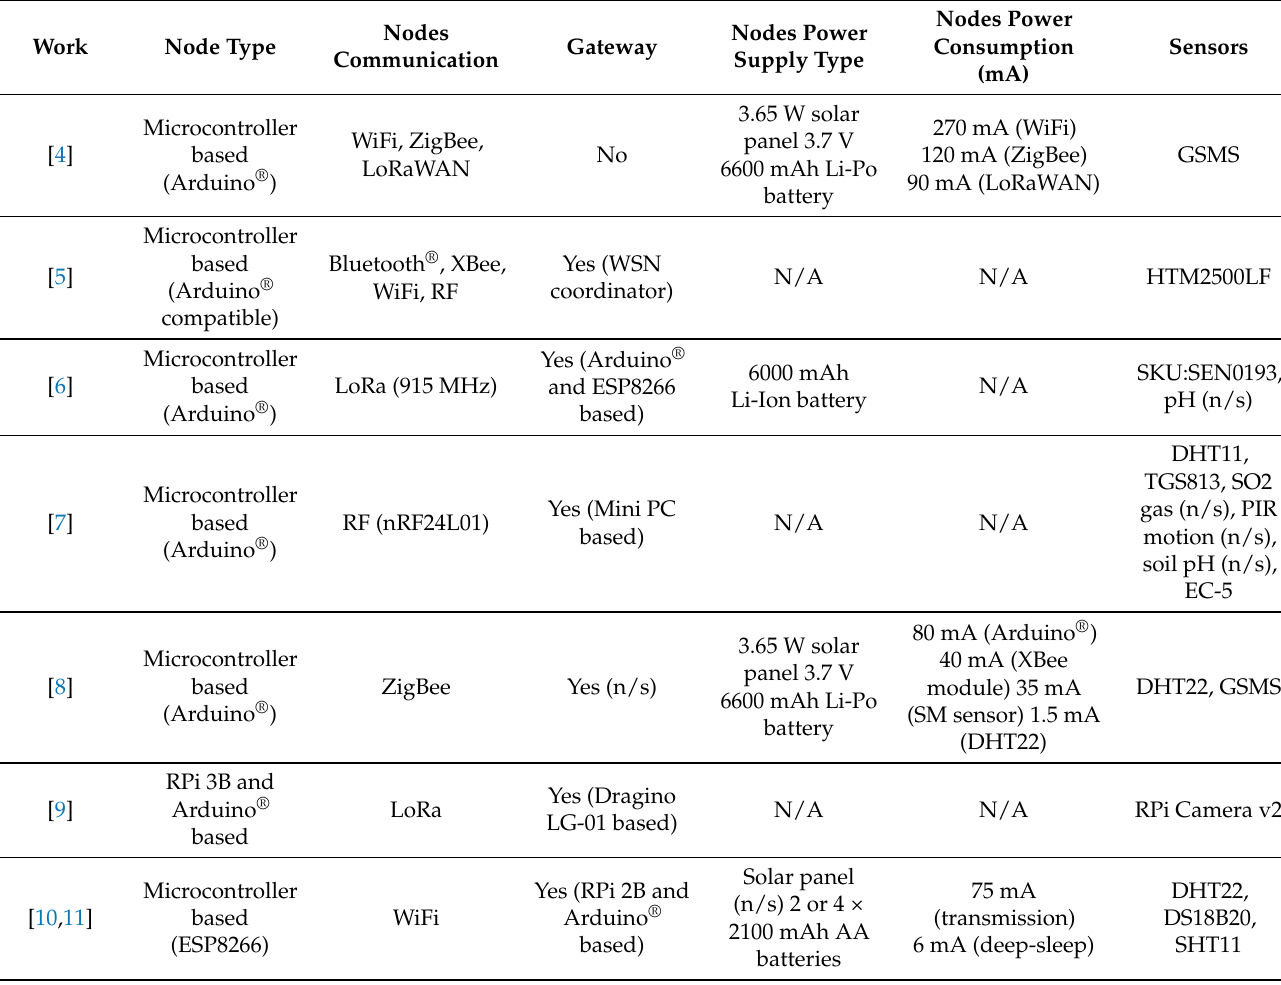
Table 1. Research works published in past five years (2017–present) related to the use of data acquisition devices in PA/PV